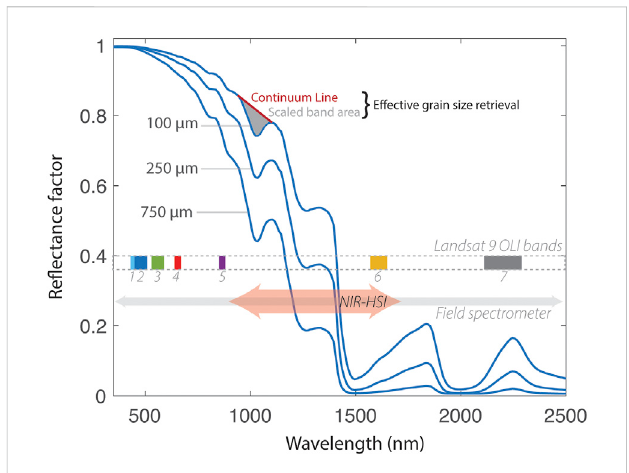
FIGURE 1 Spectral re fl ectance factors for snow having an effective grain radiusof100,250,and750 μ m.Anexampleofthescaledbandareagrain size retrieval method is shown on the 100 μ m spectra across the ice absorption feature centered at 1030 nm. The spectral resolution of theNIR-HSI(orangearrow), fi eldspectrometer(grayarrow),andLandsat 9 OLI (between dashed lines) are indicated on the